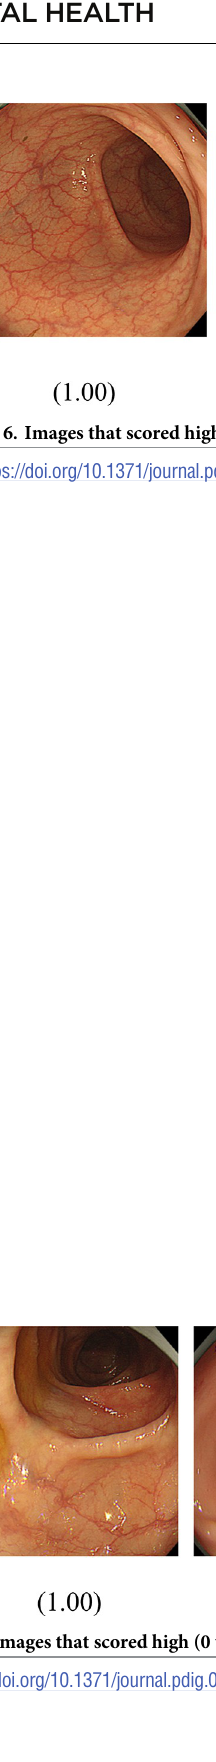
PLOS Digital Health | https://doi.org/10.1371/journal.pdig.0000058 February 17,